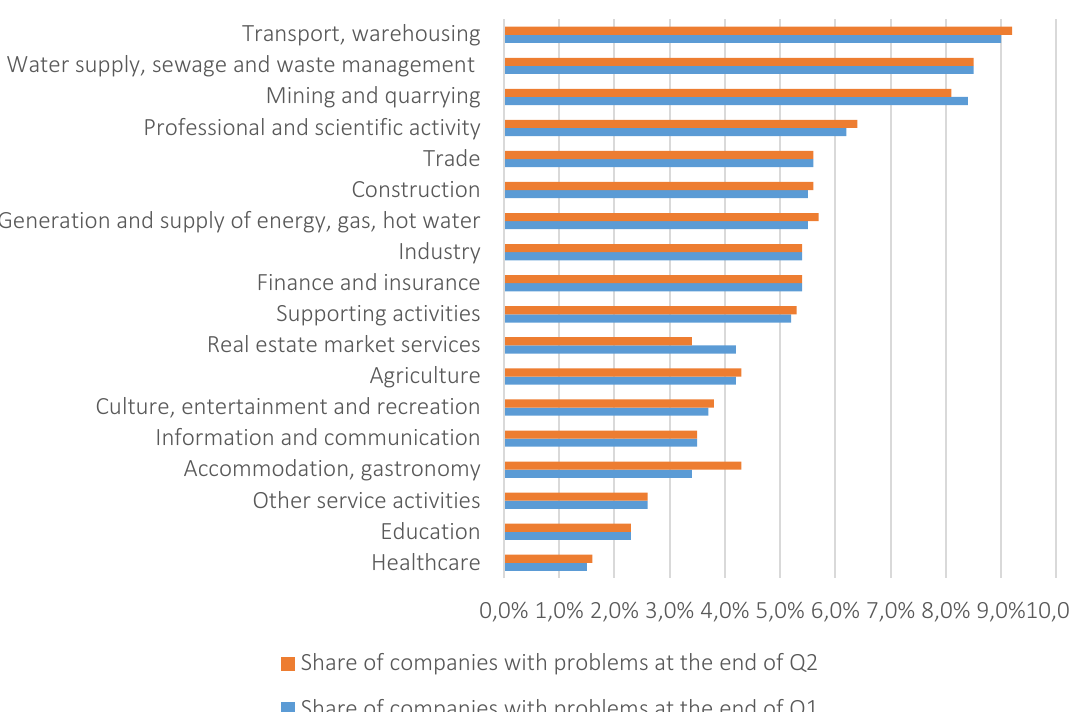
Figure 2. Share of companies with problems in a given sector at the end of Q1 and Q2